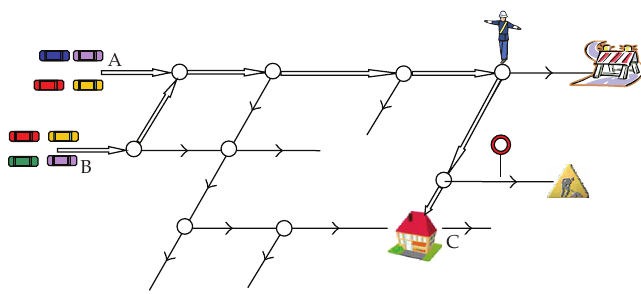
Figure 1: Example of car flows